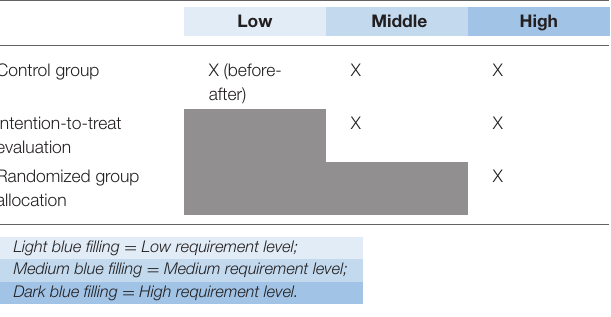
TABLE 2 | Study design characteristics per requirement level.